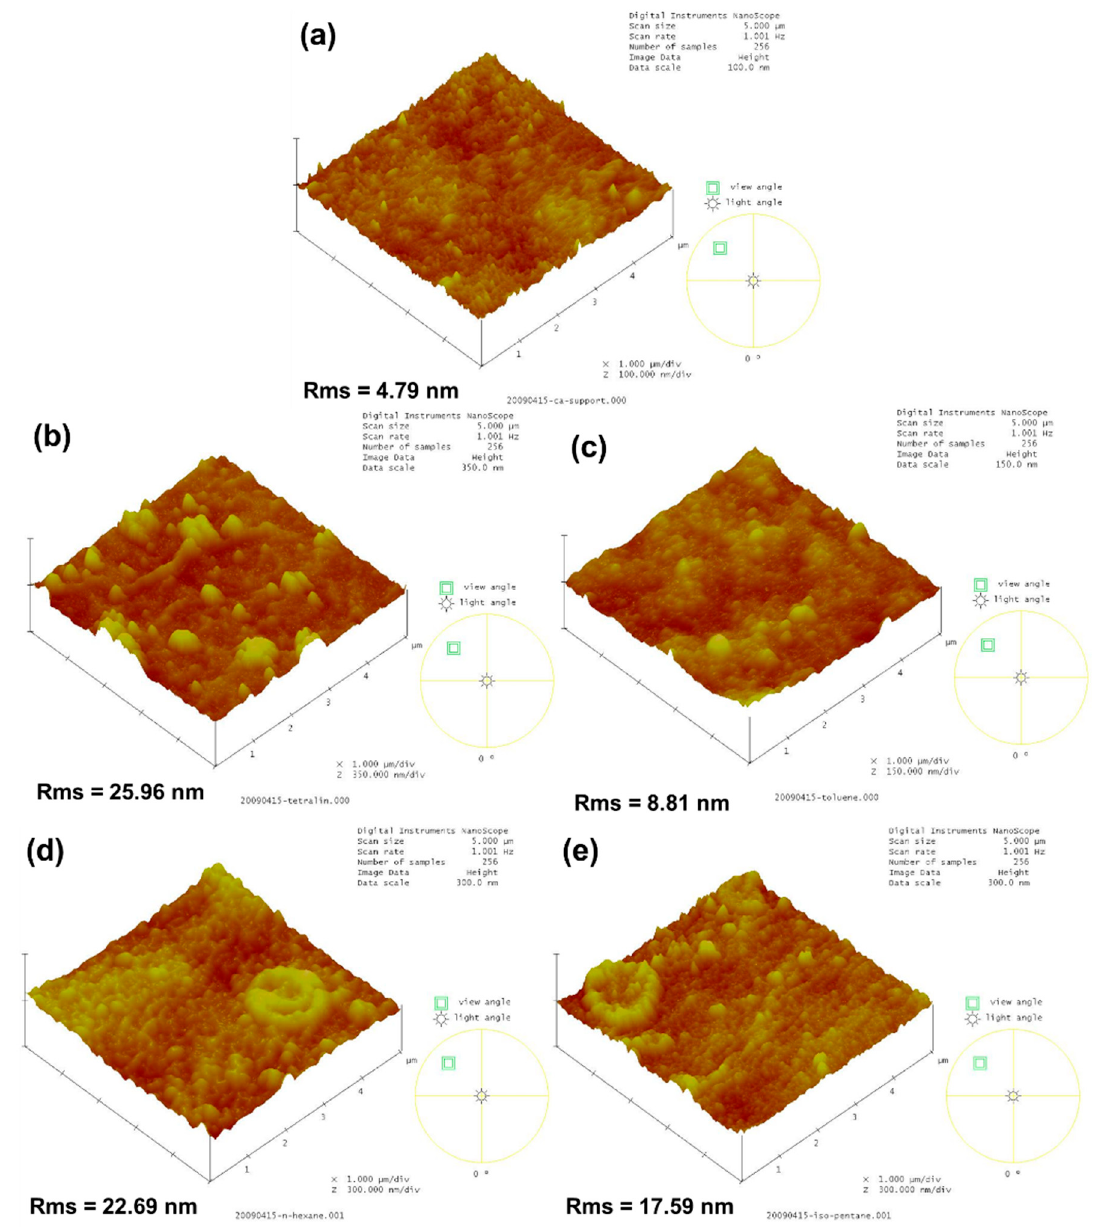
Figure 4. 3-D AFM images of ( a ) CA, ( b ) TFC tetralin , ( c ) TFC toluene , ( d ) TFC hexane , and ( e ) TFC isopentane .